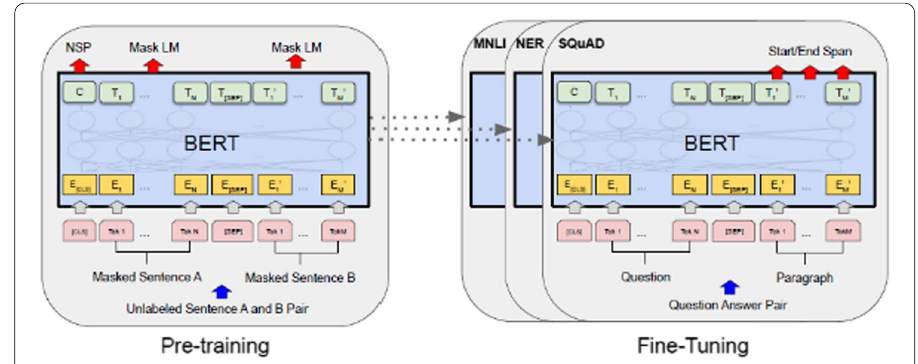
Fig. 2 Pre-training and fine-tunning procedures for BERT